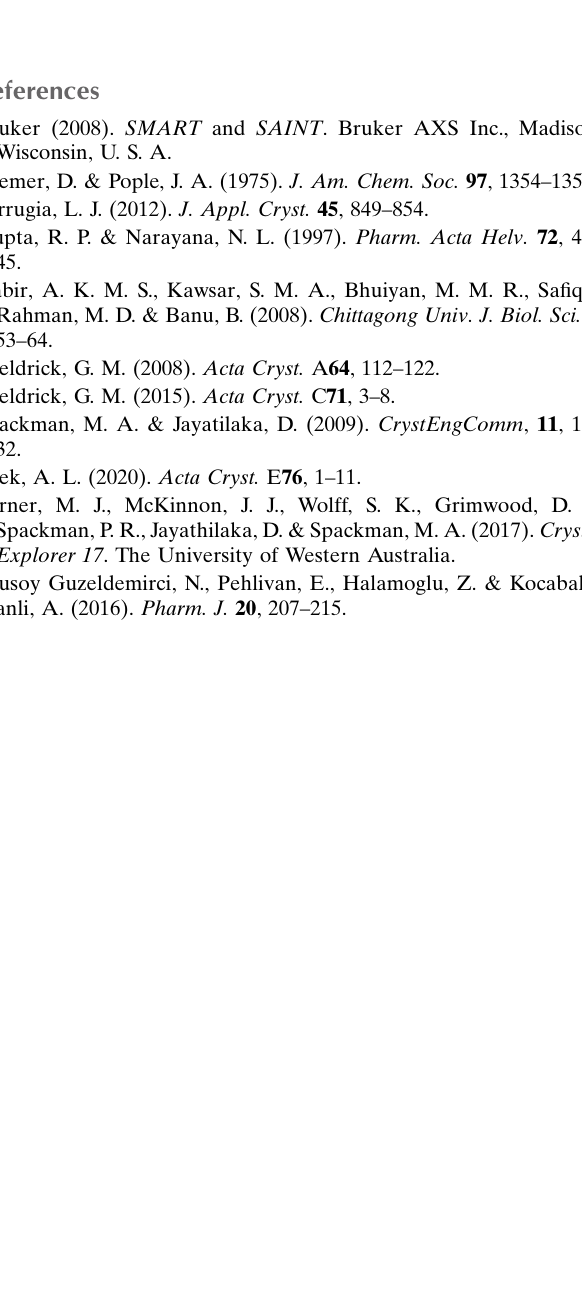
Table 2 Experimental details. Crystal data Chemical